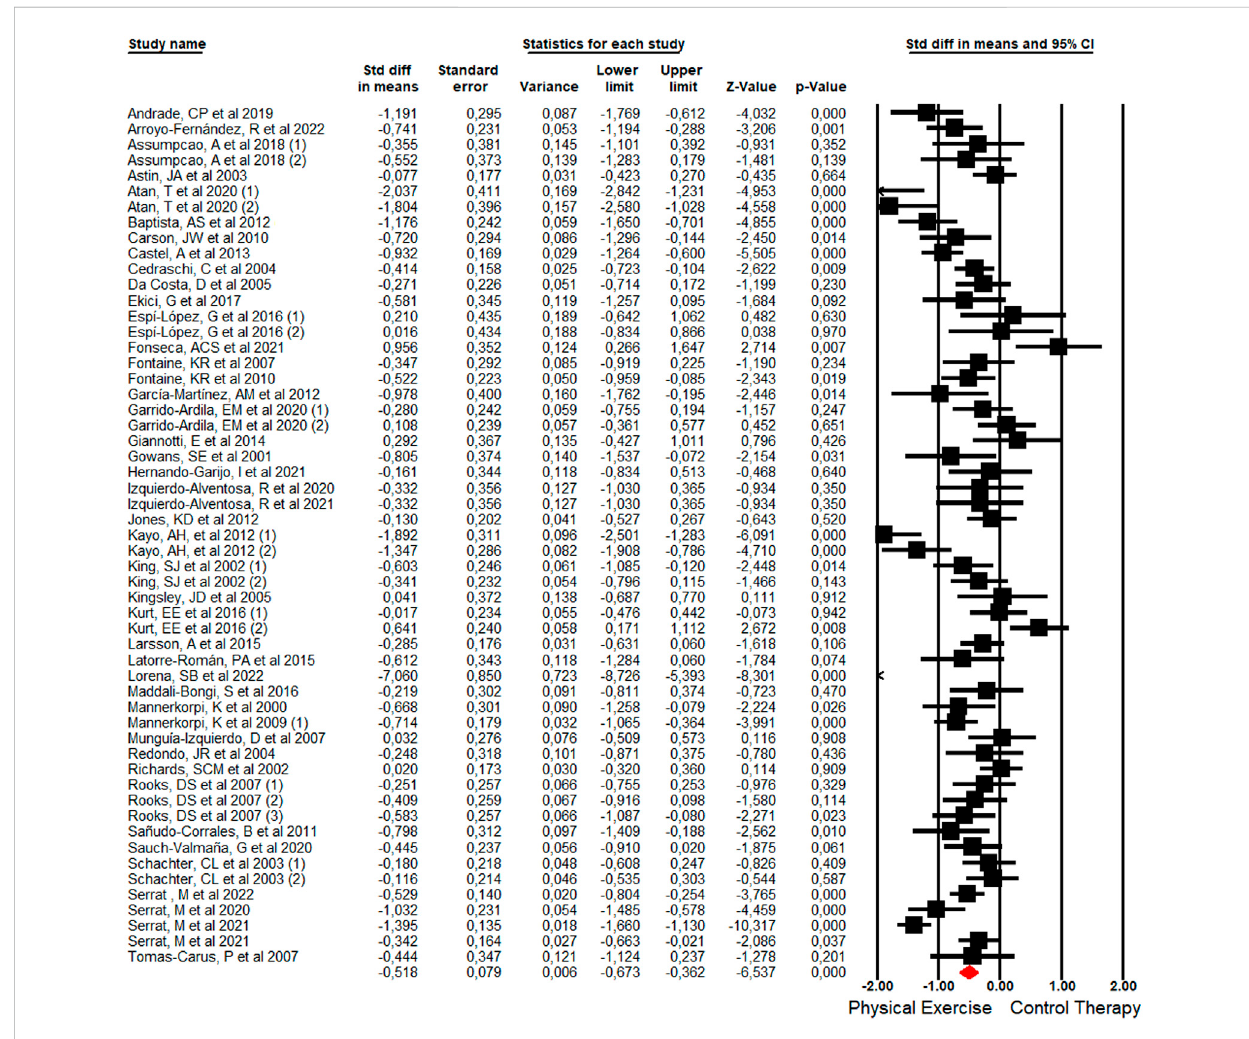
FIGURE 3 Forest Plot of the immediate effect of PEBT on FMS